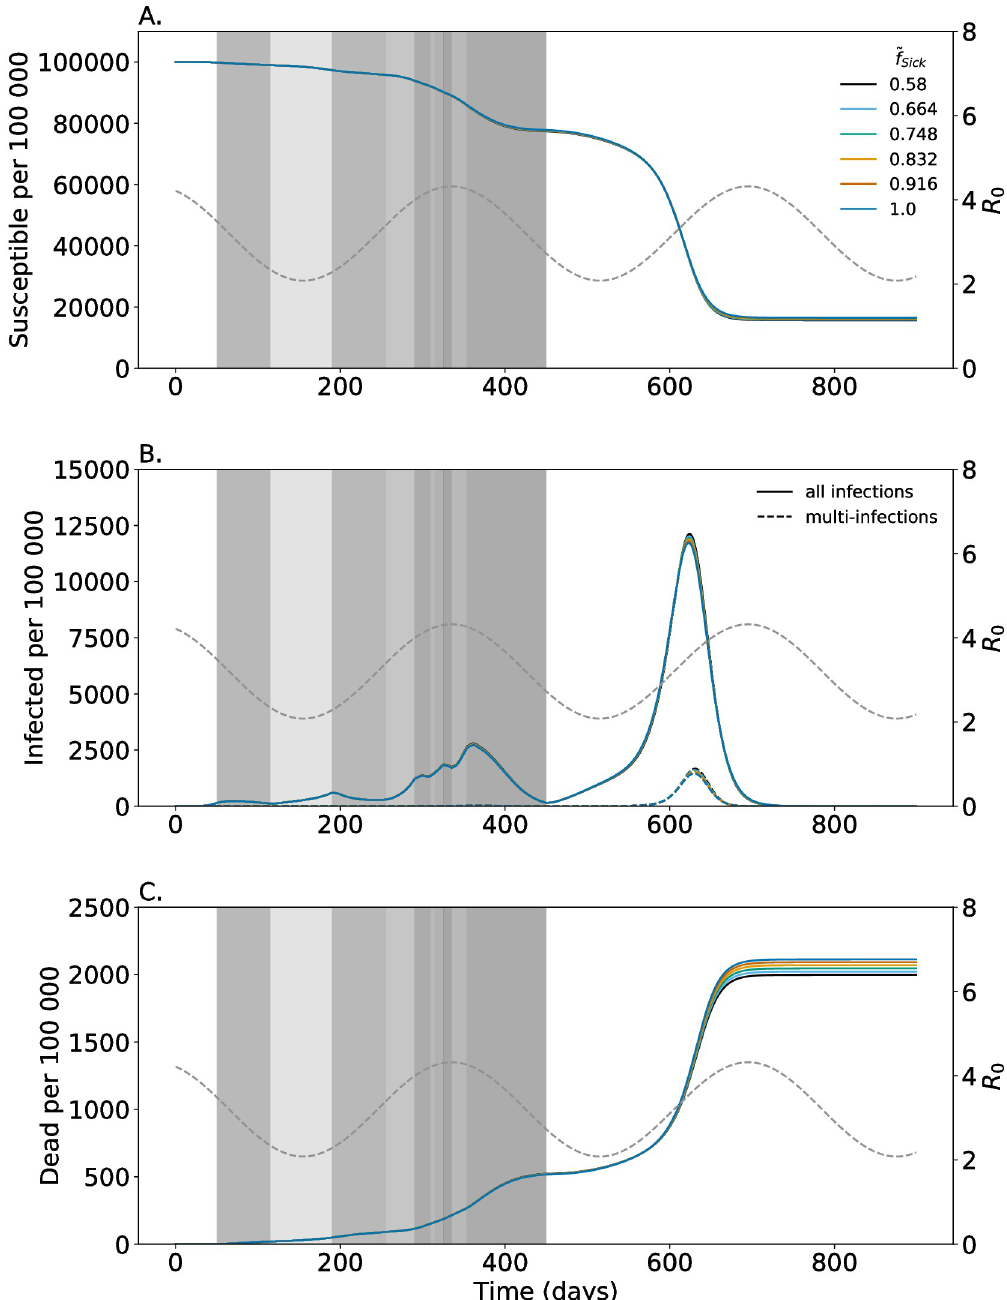
Fig 2. Proportion of multi-infected individuals being symptomatic. Shown are the numbers of susceptibles (A); (B) infected individuals consisting of all latent, prodromal, fully, and late contagious individuals among all single- and multi-infections (solid lines) and non-transient multi-infections (dashed lines); and dead individuals (C). Colors are for different fractions of multi-infected individuals that become symptomatic ( ~ f ). Seasonal fluctuations in R 0 are illustrated by the gray dashed line Sick corresponding to the y-axis on the right-hand side. Gray shadings reflect the strength ( p Dist ) of general distancing in the respective time intervals. Parameters are given in S1–S4